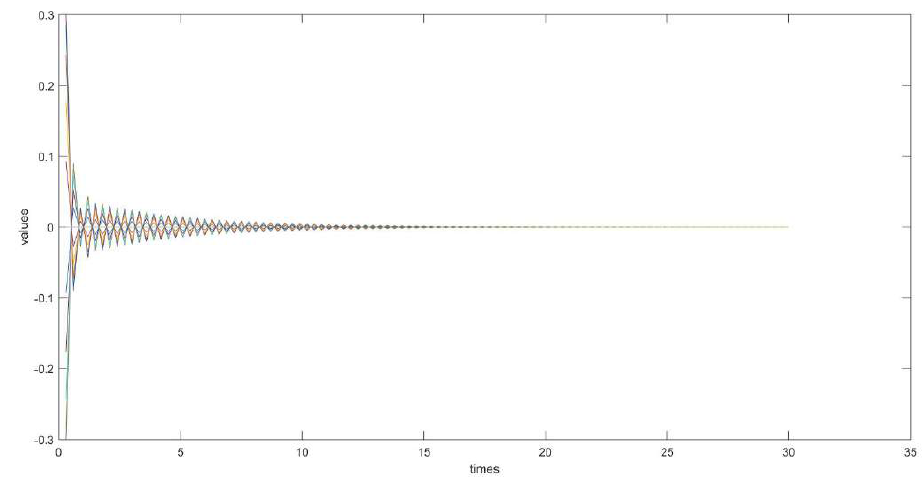
Figure 3. Convergence of solution u of (21)–(23) under control to zero in